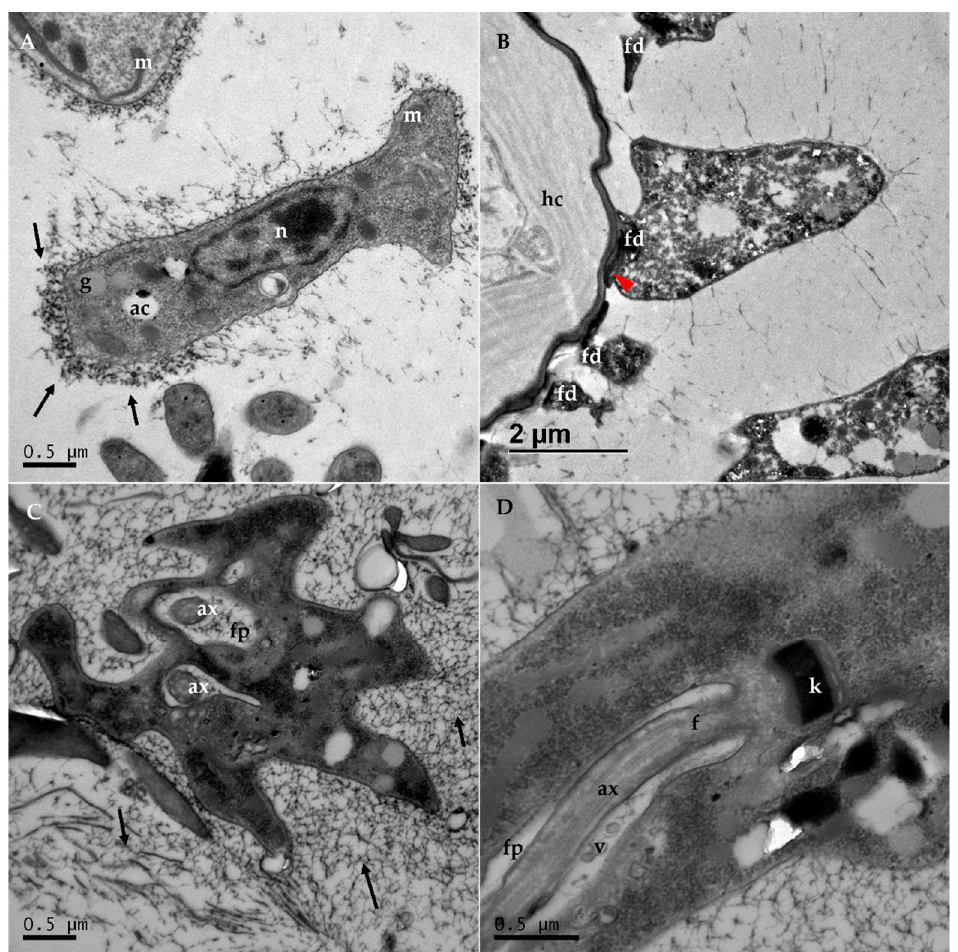
Figure 2. Transmission electron microscopy (TEM) images obtained from the rectum of C. acantho- cephali infected bees: ( A ) longitudinal section of an adherent haptomonad form, with the elongated nucleus (n) visible on the central part of the cell body, with condensed heterochromatin both centrally and around the nuclear membrane, as well as some organelles as acidocalcisomes (ac) and glycosomes (g). A network of fibers of unknown nature can be observed around the trypanosomatid, especially in the posterior part of the cell (black arrows). ( B ) Haptomonad cell attached to the host cell (hc). Some flagellapodia (fd) that remain attached could also be observed, even though their cell bodies seem to be lost or are not in the same section. ( C ) Cross-section of a haptomonad cell undergoing division, in which two flagella axonemes (ax) can be observed inside both flagellar pockets. ( D ) Detailed longitudinal section of a haptomonad cell. The flagellar body (f), with the axoneme visible (ax), is located within half of the length of the cell body, right before the kinetoplast (k). Some vesicles (v) are observed inside the flagellar pocket, while other organelles, such as the mitochondria (m), are also observed in the cell